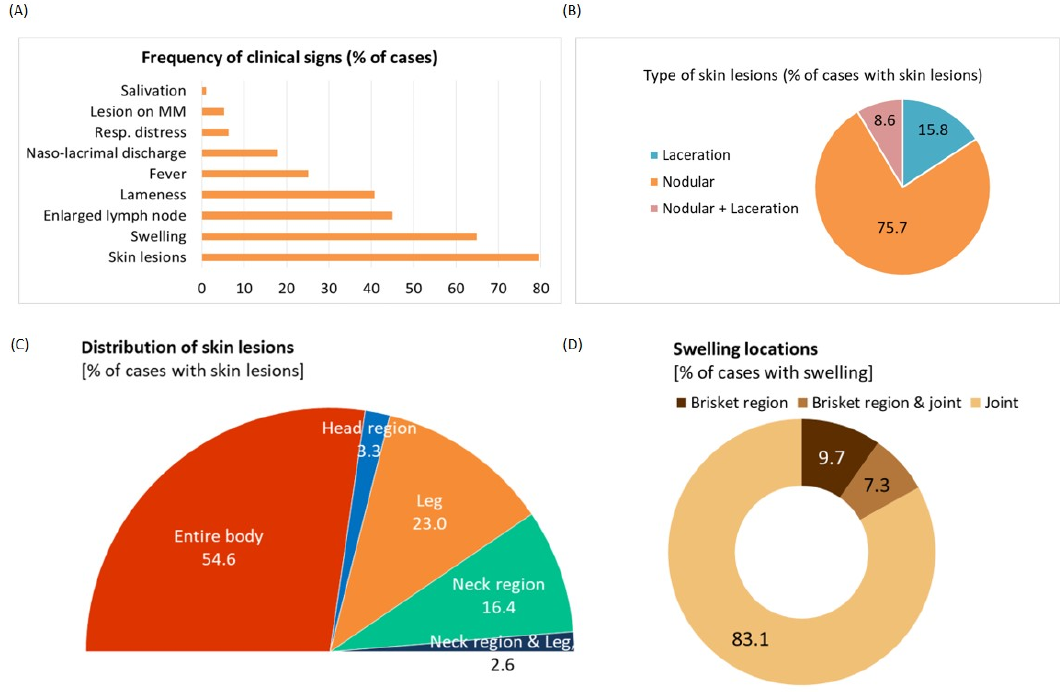
Figure 1. Clinical observations and distribution of lesions of the affected cattle population. ( A ) Fre- quency of clinical signs shown by the affected cattle. ( B ) Pie chart showing the type of skin lesions that were classified as nodular, laceration, and both. ( C ) Half pie chart showing the distribution of skin lesions in different parts of the body. ( D ) Pie chart revealing the occurrence of swelling in dif- ferent body parts.